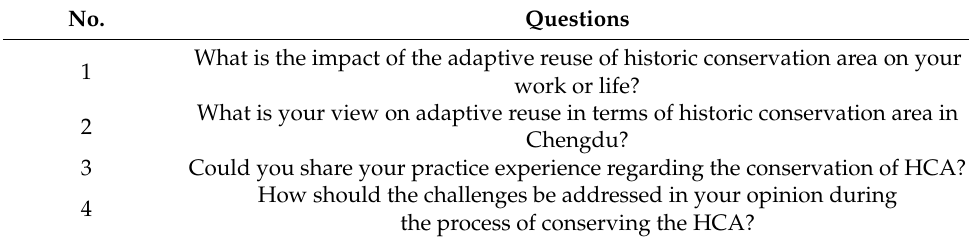
Table 2. Key interview questions.